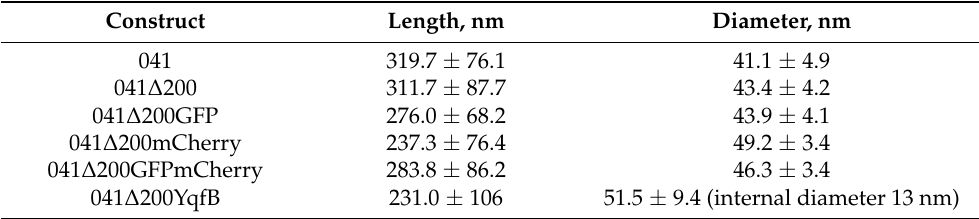
Figure 3. Electron micrographs of nanostructures formed by recombinant protein 041 and its modified variants. Table 3. Characterization of the recombinant